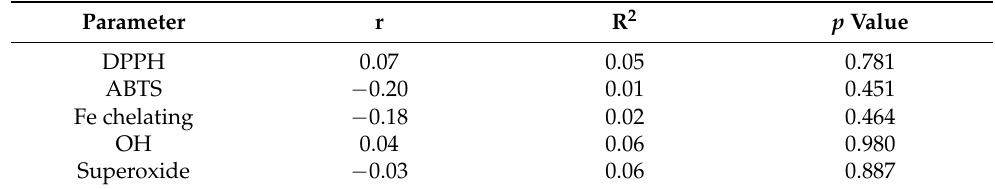
Table 4. Linear correlations between antioxidant activity and concentration of carboxyl groups (COOH).